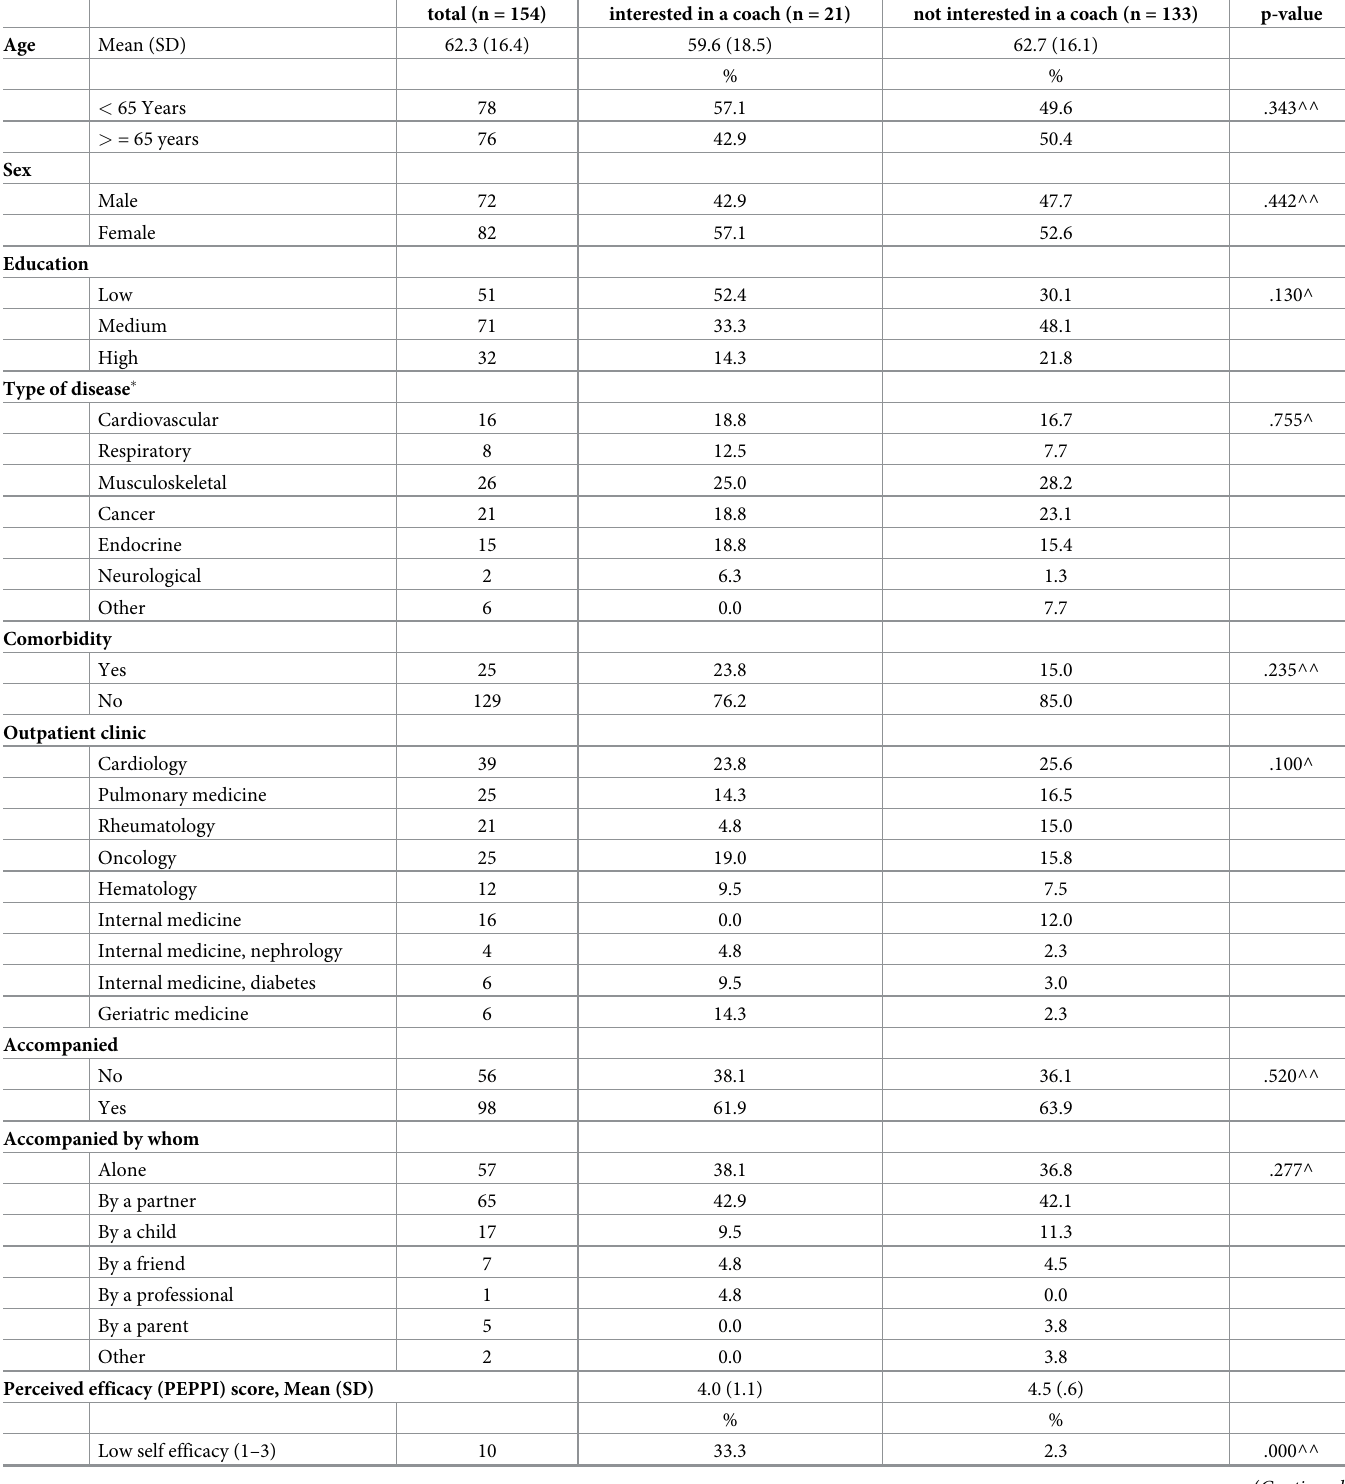
Table 1. Characteristics of the patients who completed the